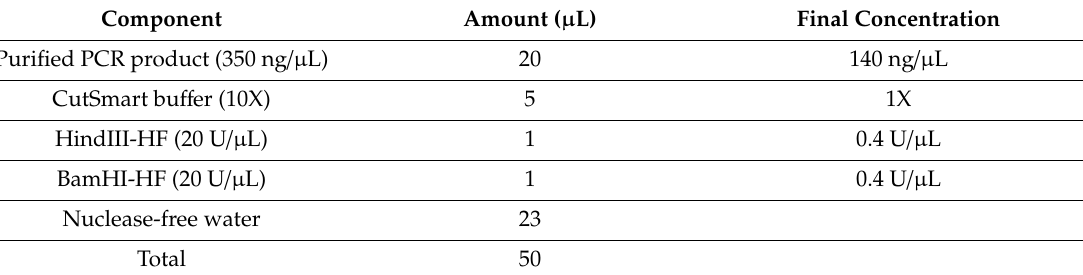
Table 3. Reaction mixture for the digestion of the PCR product.